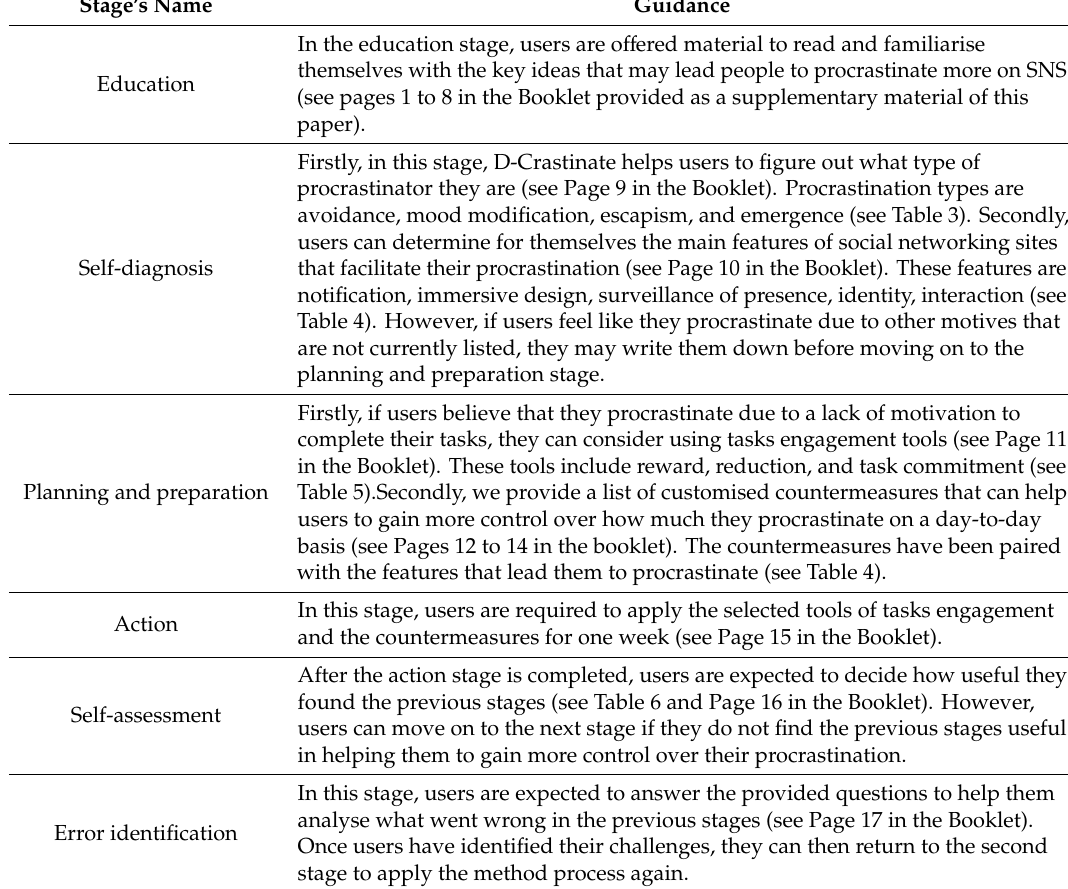
Table 2. Guidance for applying D-Crastinate